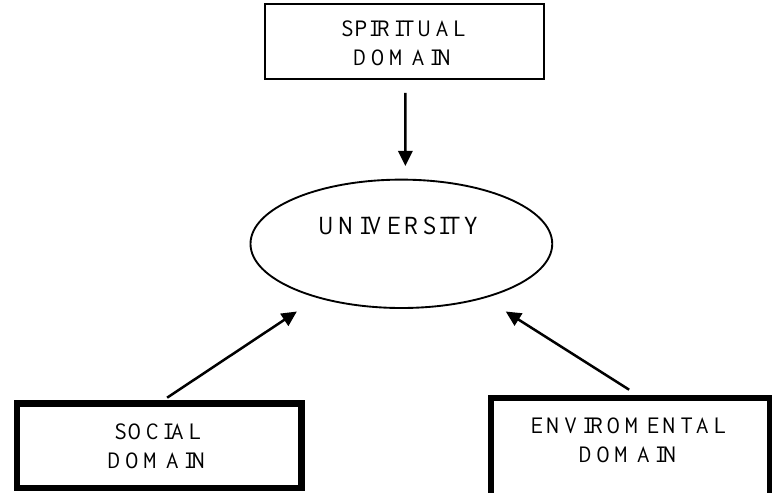
Figure 1.1 The Domains of Organization based on Tri Hita